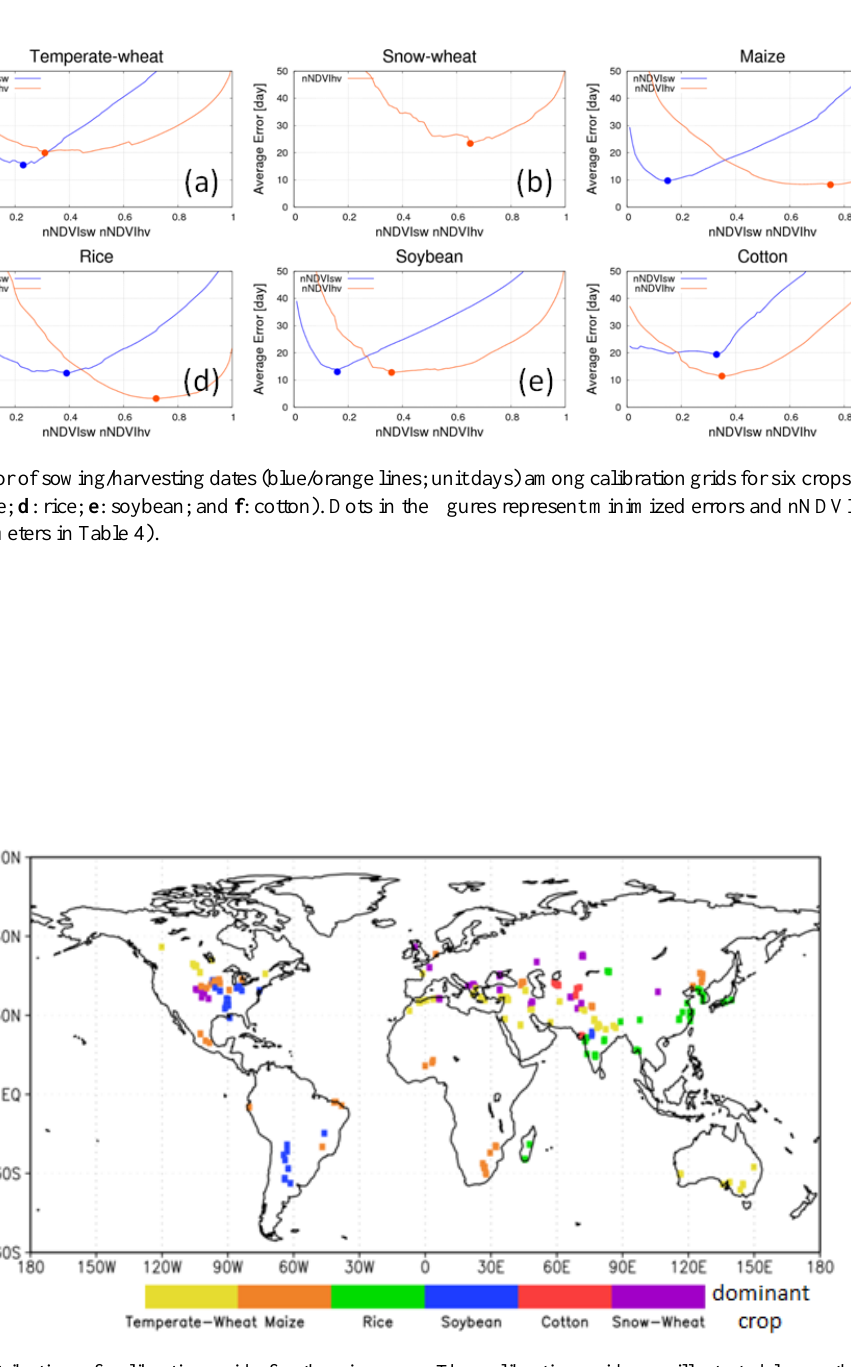
Figure A2. Global distribution of calibration grids for the six crops. The calibration grids are illustrated larger than the real grid size (5arcmin) for